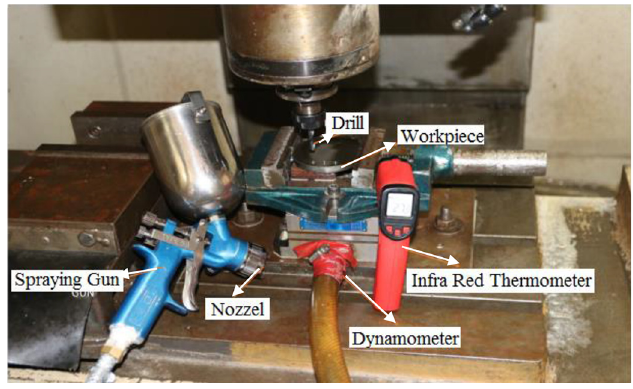
Fig. 1. Equipment Setup Used (cid:1) Nano fl uid mixed MQL